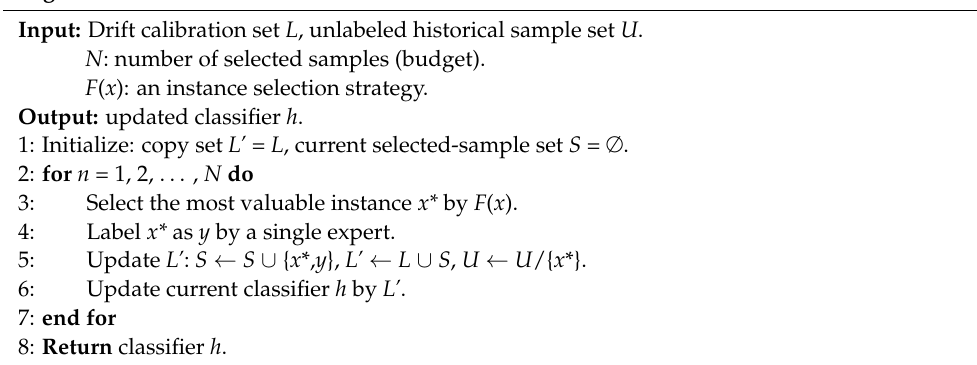
Algorithm 1. Traditional AL-based drift calibration